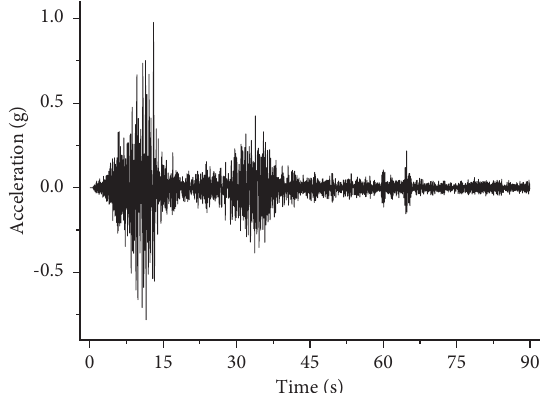
Figure 7: Accelerometers buried in the simulation material.